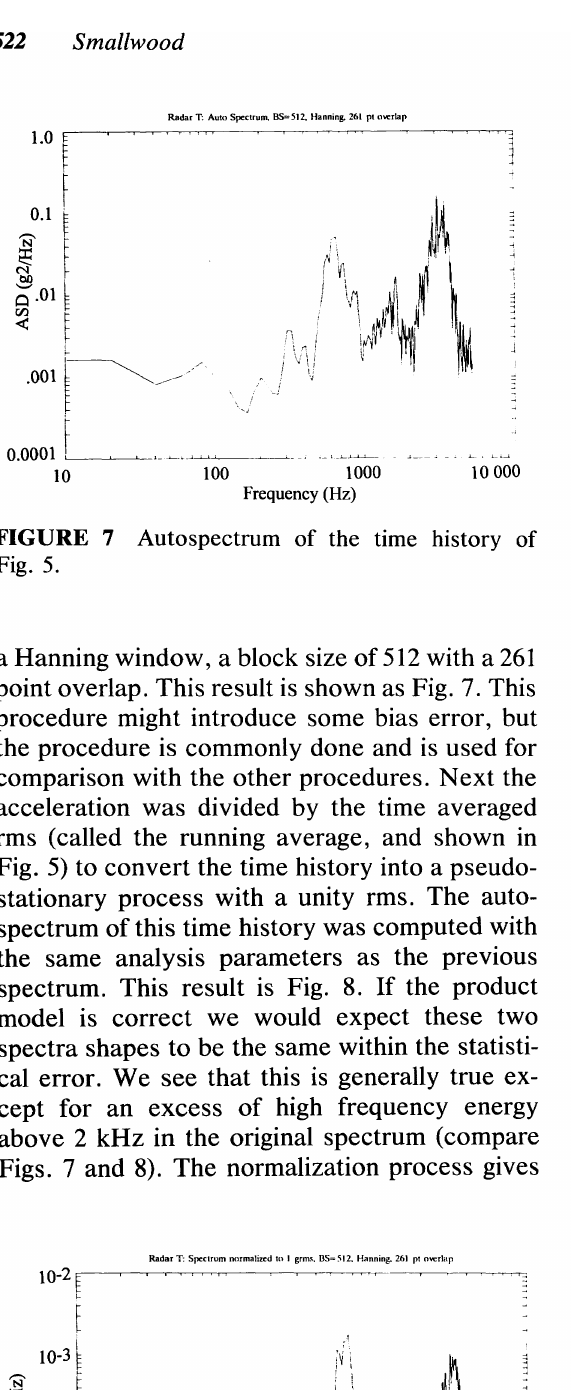
FIGURE 8 Normalized autospectral density of the time history of Fig. 5.